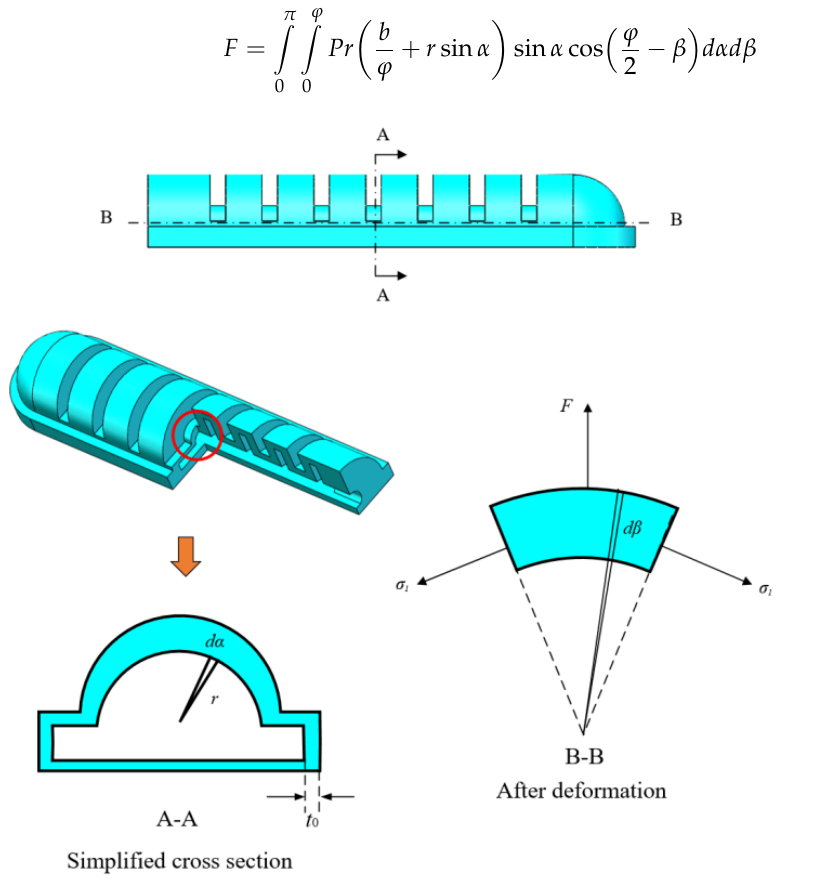
Figure 9. Cavity bending force balance diagram.